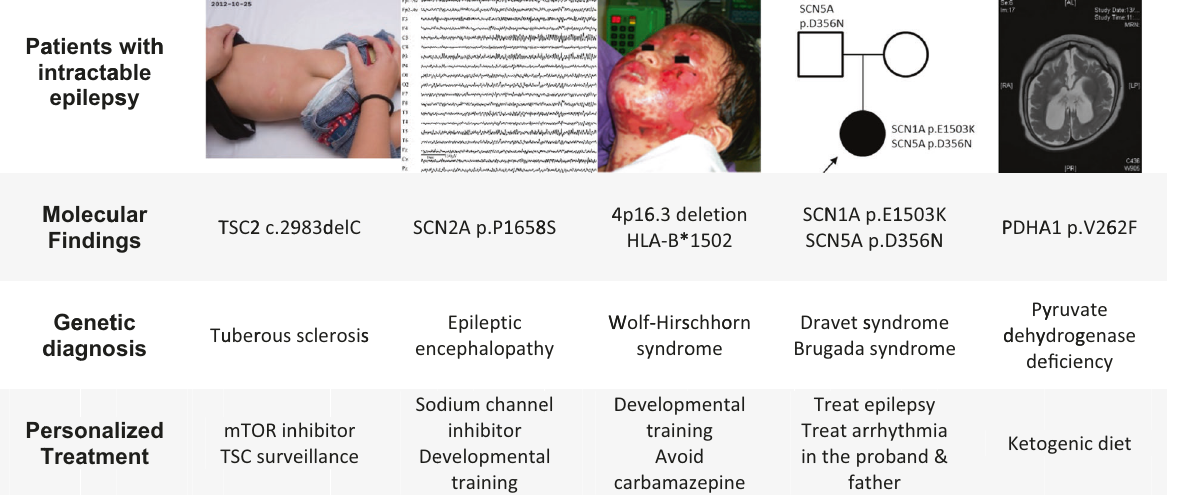
Fig. 1 Five different epilepsies, fi ve different treatments. Worldwide, ~50 million people have epilepsy, making it one of the most common neurological diseases. Pediatric ‐ onset intractable cases are de fi ned by onset before 18-years-of-age with two failed trials of tolerated appropriately-chosen-and-used anti-epileptic drugs (AED) to achieve sustained seizure freedom. An estimated 30% of epilepsy patients fall into this category. Diverse disease etiologies make accurate and speci fi c diagnoses challenging. From the ClinGen Epilepsy Gene Curation Expert Panel 35 , there are 2702 genes associated with epilepsy. A proper molecular diagnosis is therefore essential. Here, we show fi ve examples from the University of Hong Kong (HKU) Paediatric Exome Project, demonstrating how genome medicine enables personalized treatment of dif fi cult epilepsy cases 36 . Informed consent was obtained from the parents for the use of these clinical photographs. Fig. 2 Summary of disease prevalence from Orphanet. Data are sorted from most to least common disease. The solid red line is the